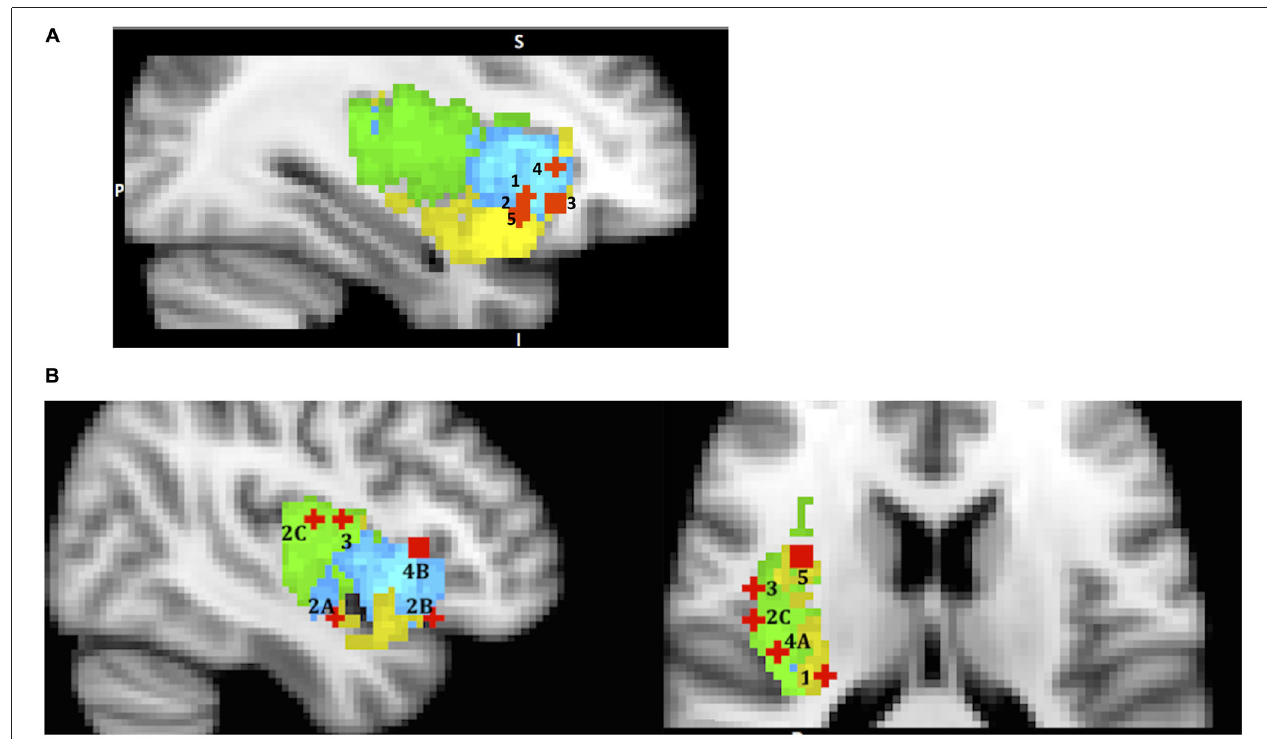
FIGURE 3 | A sample of studies addressing the IC’s role in Evaluation Phase (for illustration purposes only). Sub-regions of the Insula: posterior (green), dorsal anterior (blue) and ventral anterior (yellow). IC activations related to (A) 1 – mean difference in Wu et al. (2012) (36, 19, − 5); 2 – variance in Wu et al. (2012) (36, 16, − 9); 3 – skewness in Wu et al. (2011) (33, 26, − 7); 4 – risk prediction in Preuschoff et al. (2008) (37, 25, 1); 5 – risk prediction error in Preuschoff et al. (2008) (36, 17, − 11); (B) (urge processing) 1 – smoking cue reactivity in Engelmann et al. (2012) ( − 28, − 26, 14); 2 – alcohol cue reactivity in Myrick et al. (2004) (A) (41, − 5, − 14); (B) (47, 22, − 13) C in Tapert et al. (2004) (47, − 11, 15); 3 – cocaine cue reactivity in Garavan et al. (2000) (45, − 4, 14); 4 – consciousness of thirst in Egan et al. (2003) (A) (39, − 20, 18) and (B) (43, 19, 6); 5 – sexual arousal in Safron et al. (2007) (34, 5,